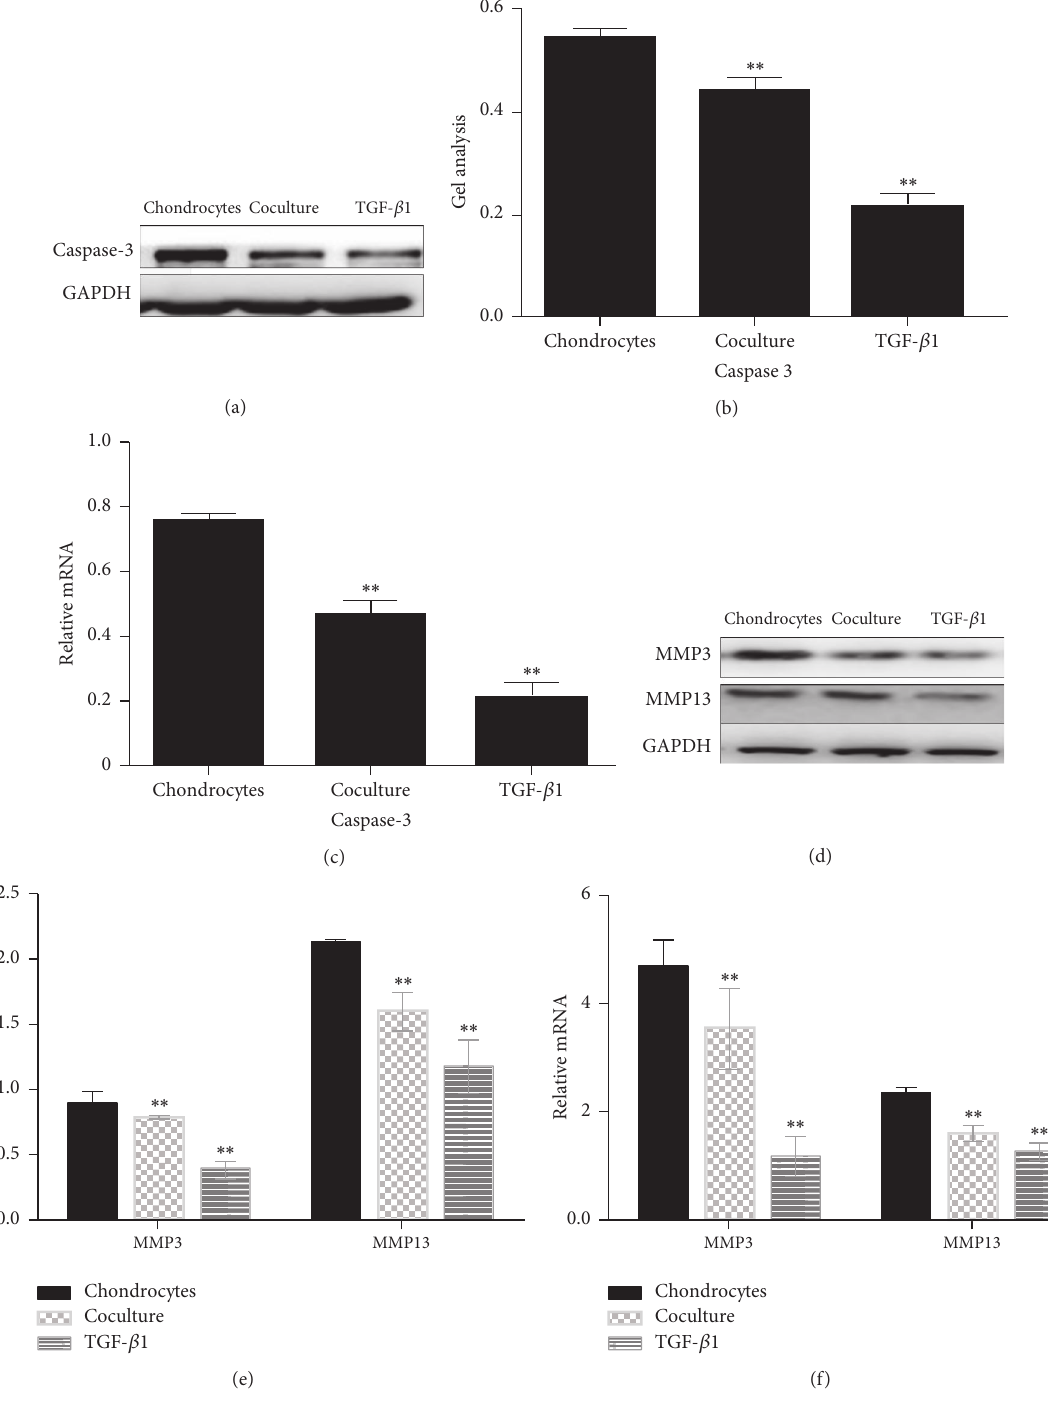
Figure 8: Expression of catabolic markers on chondrocytes cultured with three different conditions for 5 days and determined by western blot ((a), (b), (d), and (e)) and real-time PCR ((c), (f)). Caspase-3 protein was downregulated in chondrocytes when they were cultured with ADSCs cocultured system and TGF- 𝛽 1-containing medium ((a), (b)). The mRNA level of caspase-3 was also decreased in chondrocytes cultured with ADSCs cocultured system and TGF- 𝛽 1-containing medium (c). Furthermore, both MMP3 and MMP13 were suppressed in chondrocytes cultured with ADSCs cocultured system and TGF- 𝛽 1-containing medium tested by western blot ((d), (e)) and real-time PCR (f). Data are shown as mean ± SEM. ∗∗ 𝑝 < 0.01 versus chondrocytes